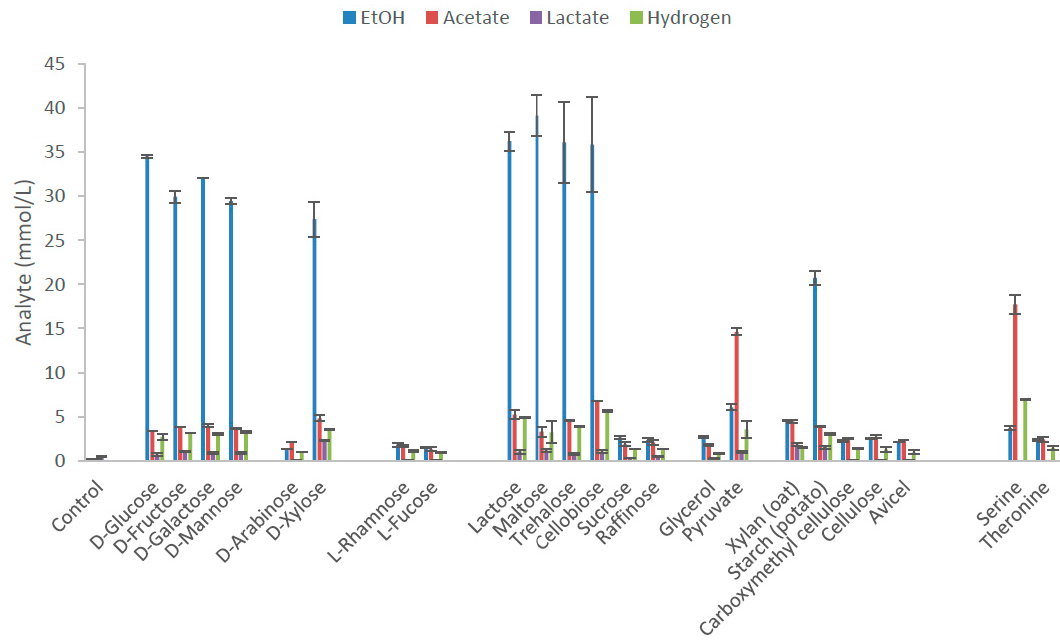
Figure 2. End product formation after 5 days by Thermoanaerobacter strain AK152 for selected carbon sources (65 °C, pH 7.0) at a concentration of 20 mM with the exception of polymeric substrates which were provided at 0.2% w / v . Values represent average of triplicate fermentations with standard deviation presented at error